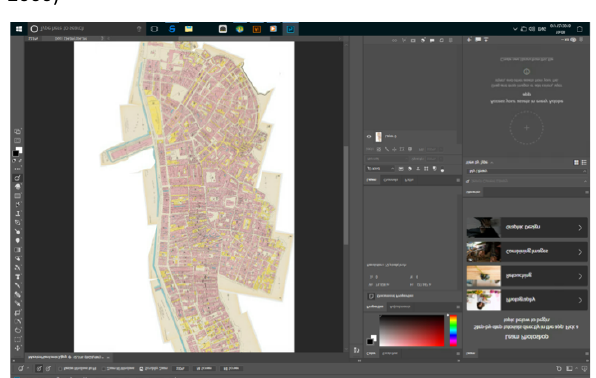
Figure – 3 Wernieski Map 1882, Thessaloniki. (Yerolympos,